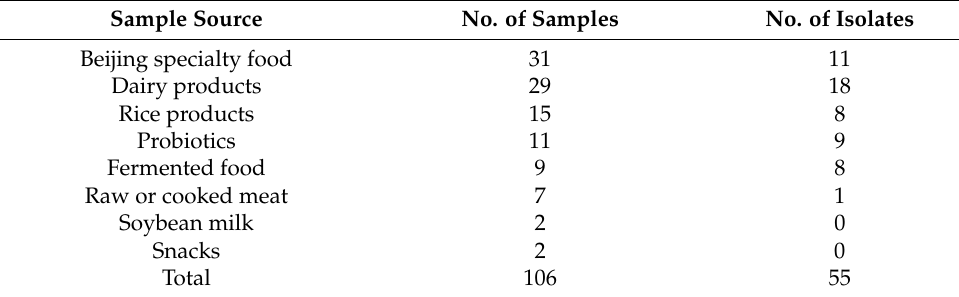
Figure 1. Proportion of different species of Bacillus isolates. B. cereus , B. licheniformis , B. subtilis and B. pumilus constitute 52.7%, 16.4%, 12.7% and 9.1% of the total number, respectively. Other species include B. amyloliquefaciens (3.6%), B. taeanensis (1.8%), B. velezensis (1.8%) and Paenibacillus cookie (1.8%). Table 1. Number of samples and bacterial isolates of different